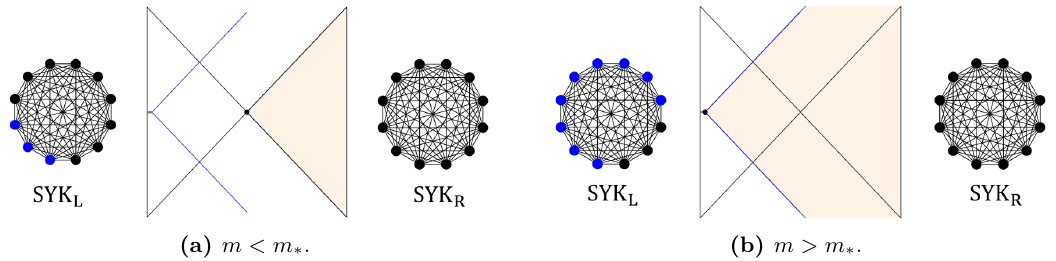
Figure 1. Measurement-induced entanglement wedge transition. Two copies of the SYK model, denoted by left and right sides, are in a thermofield double state, which is dual to a two-sided eternal AdS 2 black hole. A subset of the left Majorana fermions are measured, as indicated by blue dots. An end-of-the-world brane is created in the left asymptotic region by the measurement. The entanglement wedge of all of the right Majorana fermions is indicated by the tan region. A small gray segment on the left side indicates the cutoff region (see discussion in section 3.2). (a) When the number of measured Majorana fermions is less than a critical value, M/N = m < m ∗ , the quantum extremal surface is located at the bifurcation surface. (b) When the number of measured Majorana fermions exceeds a critical value, M/N = m > m ∗ , the entanglement wedge includes nearly the entire time reversal invariant slice. Note that the transition from (a) to (b) is a sharp phase transition in the bulk von Neumann entropy calculation, while it is a crossover in the SYK Renyi-2 entropy calculation; these are compared in figure